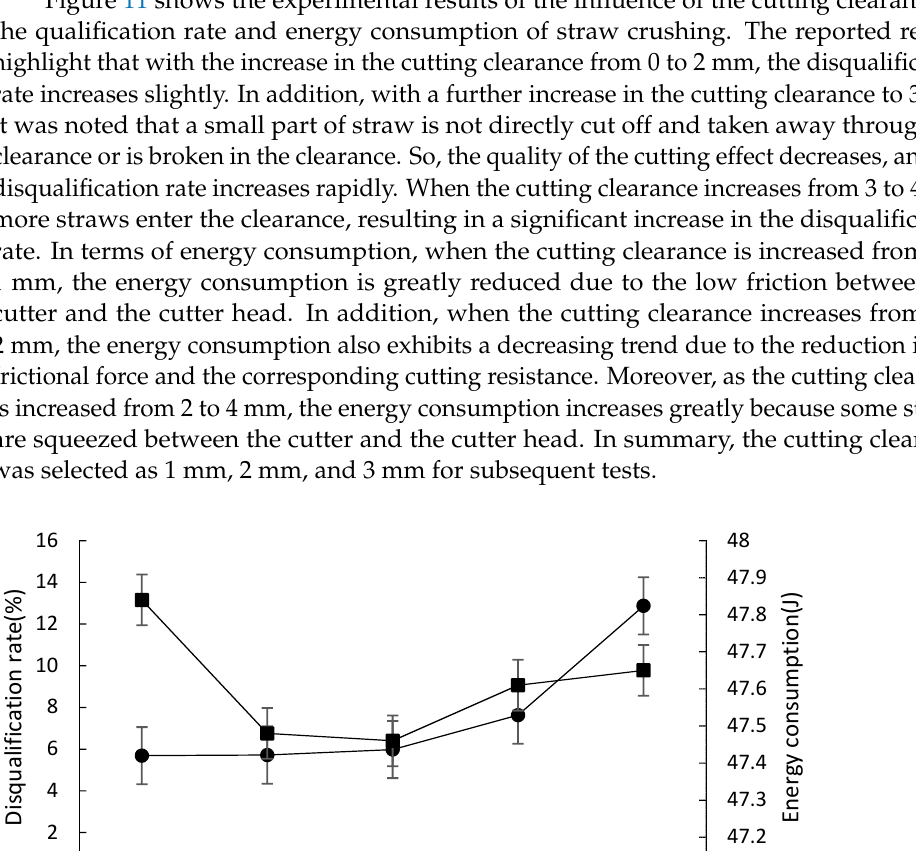
Figure 12. Experimental results of the influence of the cutter edge angle on the qualification rate and energy consumption of straw crushing.